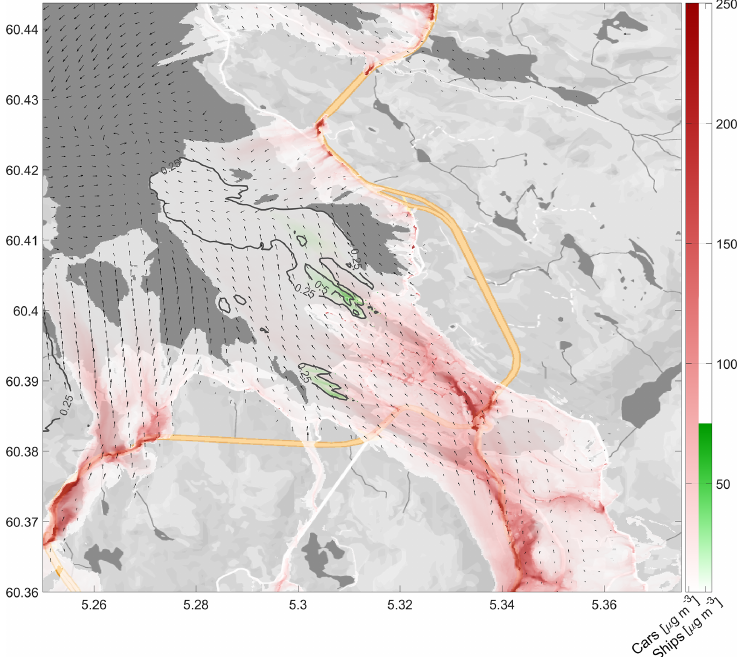
Figure 8. The same as in Fig. 7 but for the PM 2 . 5 emissions from the road traffic (red shading), ships in the harbour (green shading) and wood- burning fireplaces (blue shading). Due to the dominating impact of the emissions from wood-burning fireplaces, the red and green colours are only visible at their emission hot spots in the harbour and at the major roads in the southeastern part of the domain. The concentrations are given by semi-transparent colour shading overlaying the grayscale land and water surface taken from map data ©2019